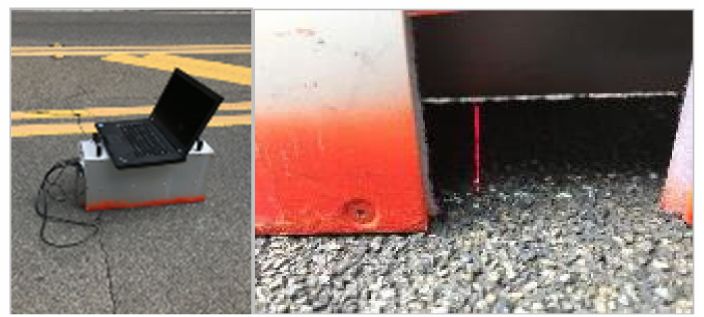
Figure 7. Laser scanner (LS-40)